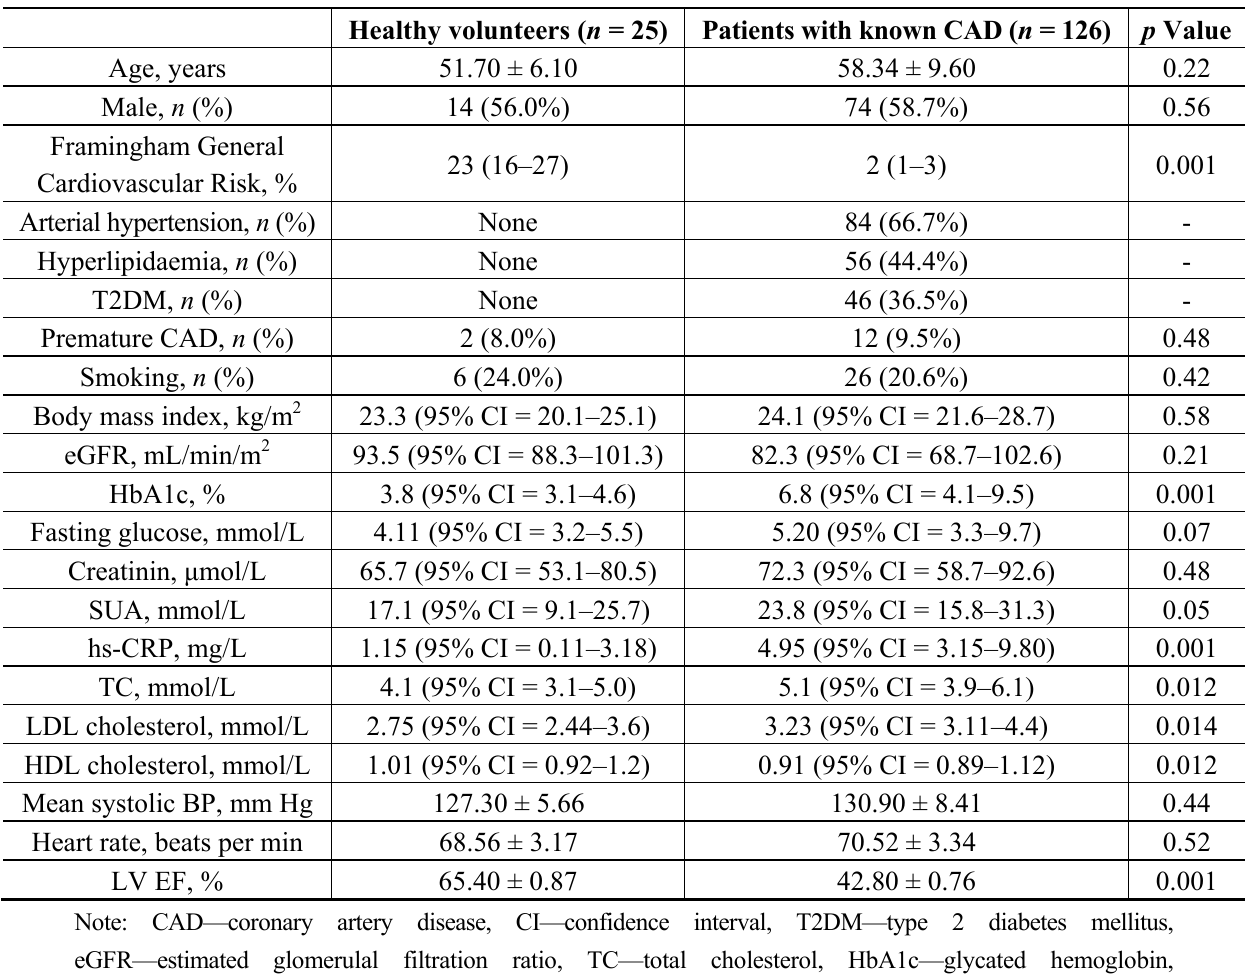
Table 1. General characteristics of study